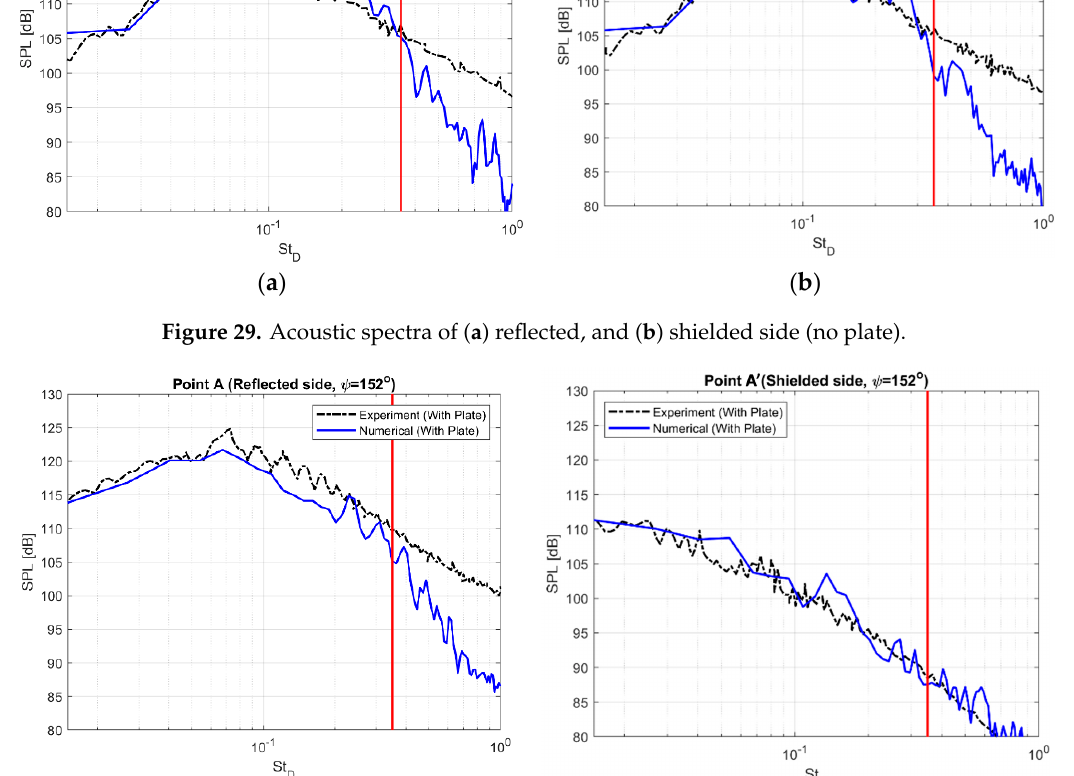
Figure 30. Acoustic spectra of ( a ) reflected, and ( b ) shielded side (with plate).